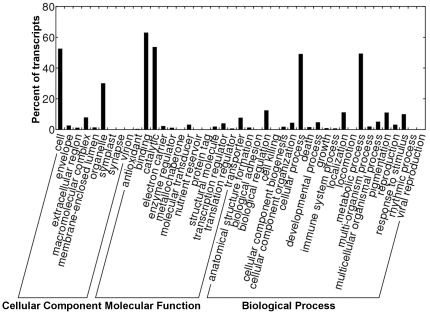
Histogram representation of GO classification.Transcripts were annotated in three categories: cellular components, molecular function and biological processes.